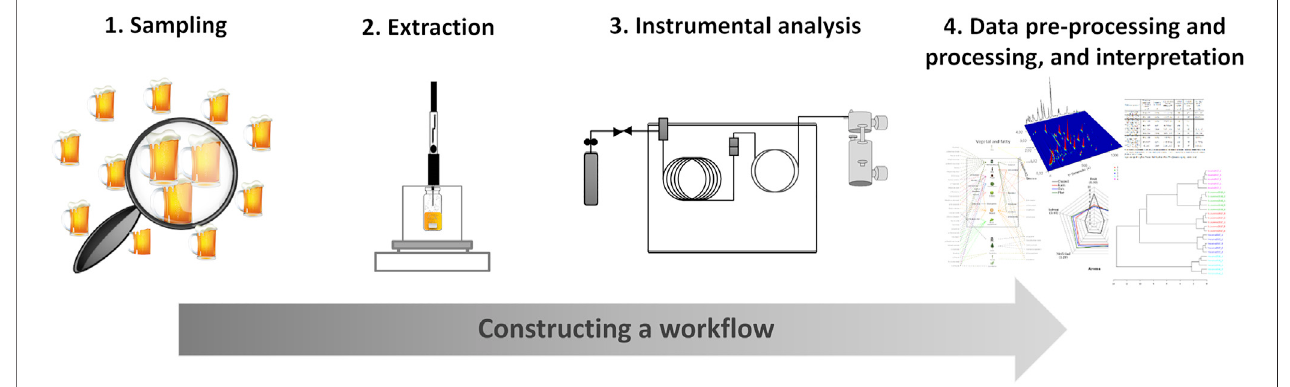
FIGURE 3 | Construction of a work fl ow toward unveiling the aroma of food